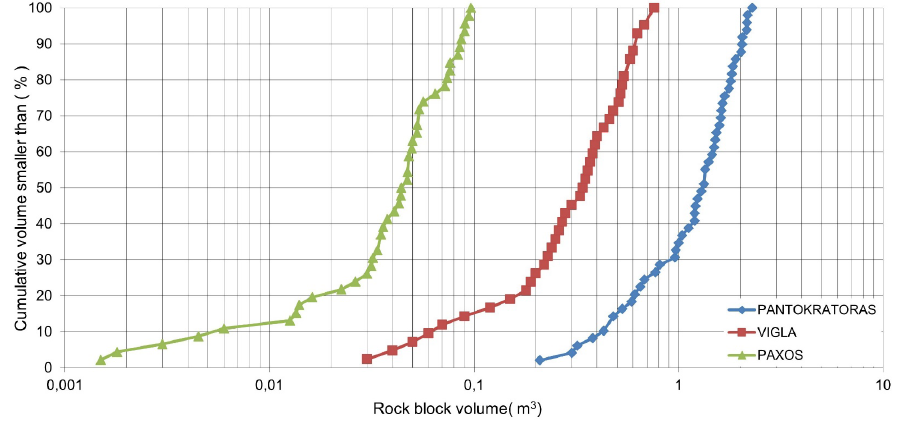
Figure 9. Cumulative distribution of in situ recorded rock block volumes.